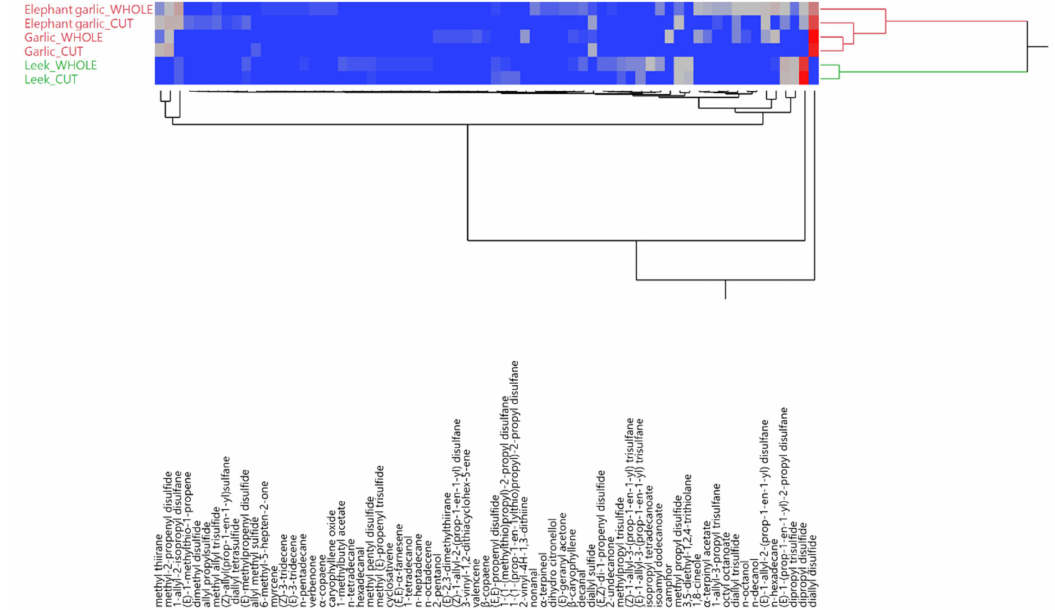
Figure 1. Two-way dendrogram of the hierarchical cluster analysis (HCA) performed on the complete compositions of the headspaces of both whole and cut samples of elephant garlic ( Allium ampeloprasum var. holmense (Mill.) Asch. et Graebn), garlic ( A. sativum L.) and leek ( A. ampeloprasum